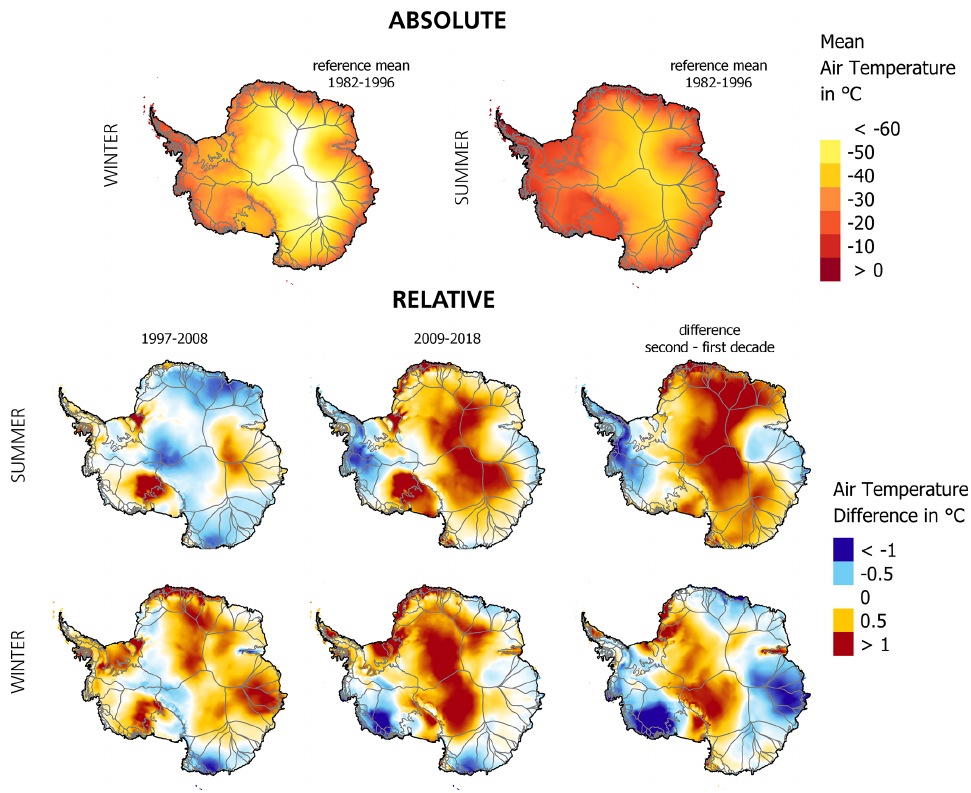
Figure 3. Absolute air temperature for the reference mean measured between 1982 and 1996 and relative changes compared to the reference mean. Additionally, the difference between the first and second decade is illustrated.